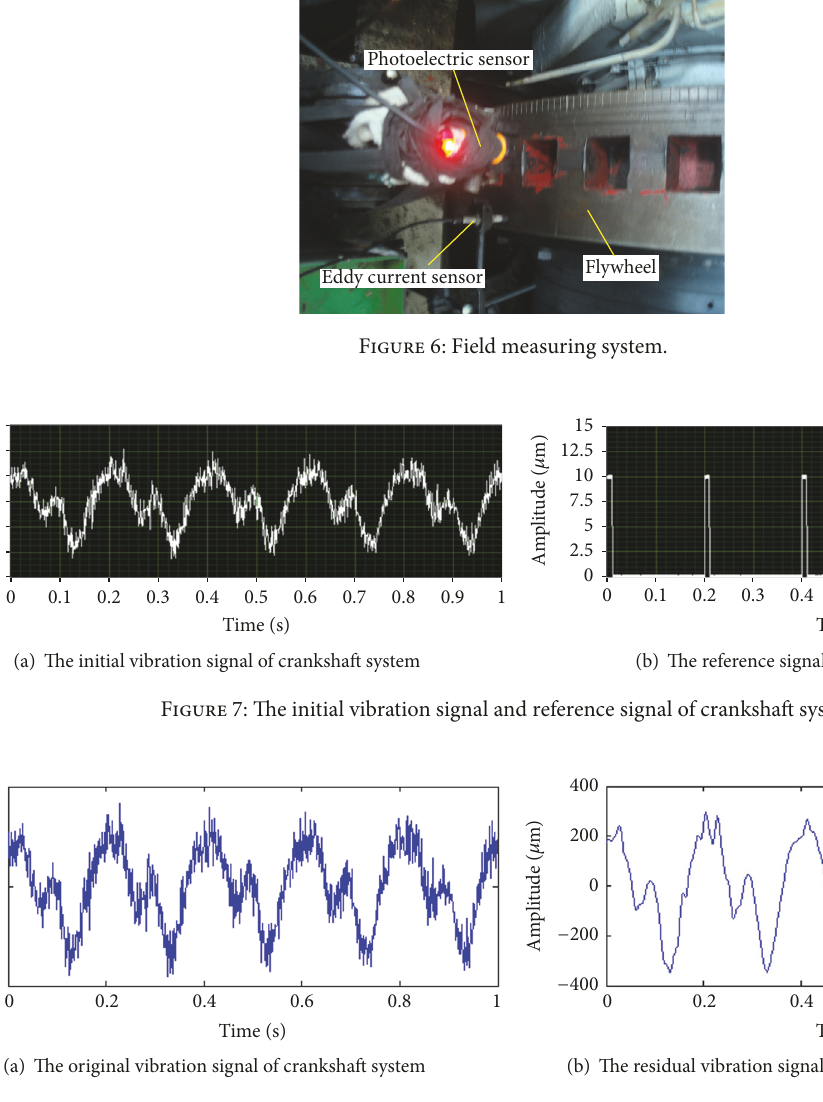
Figure 8: The filtering effect of crankshaft vibration signal based on wavelet noise reduction